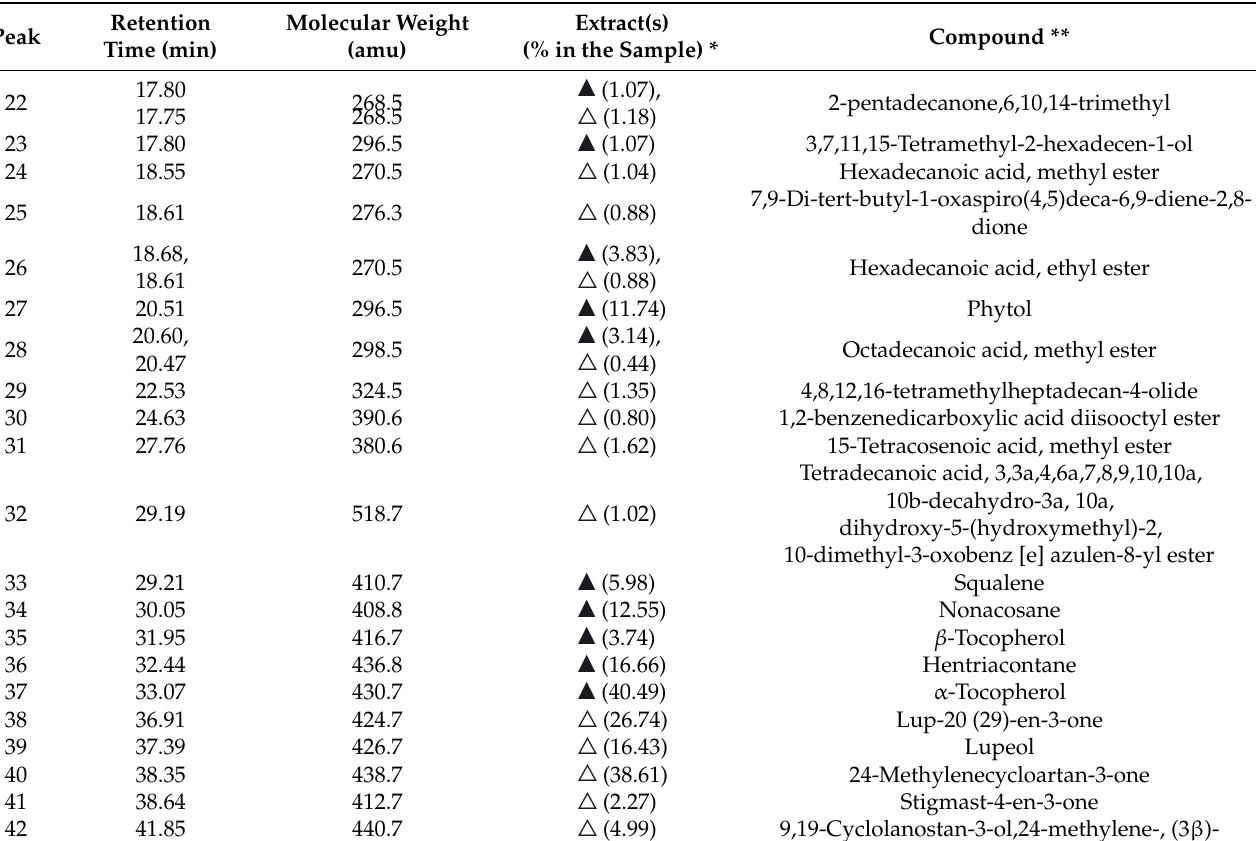
Table 3. Phytochemicals identified in hexanic extracts from the bark ( Ij-BH ) and leaves ( Ij-LH ) of Inga jinicuil by